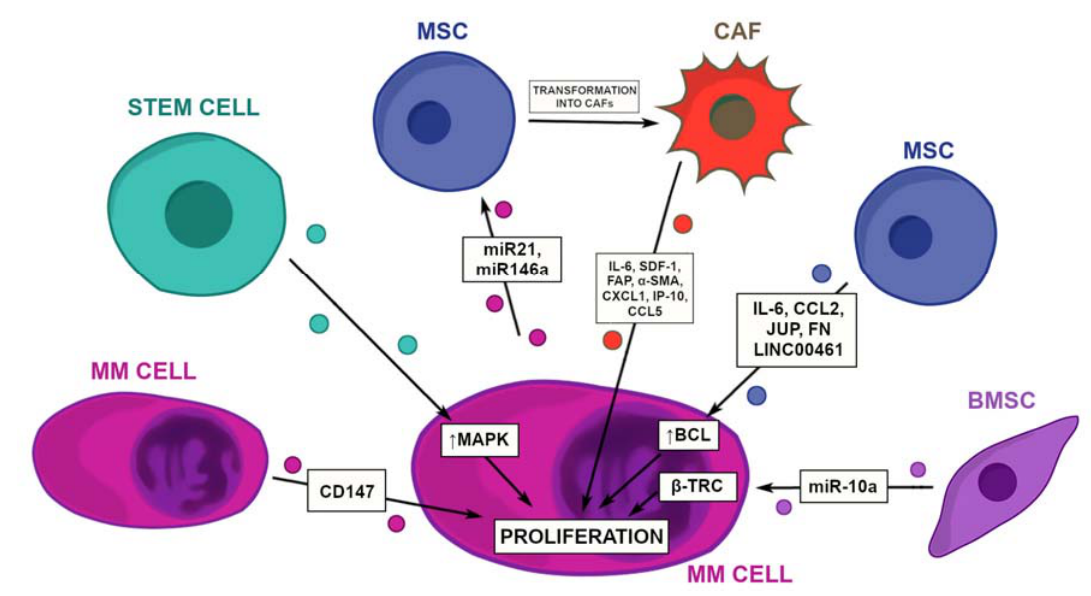
Figure 1. EVs’ involvement in the induction of the proliferation of MM cells. Interactions be- tween numerous stromal cells lead to tumor growth. MSCs send pro-proliferative cytokines, which increase the BCL-2 content inside MM cells, inducing its viability and survival. When stimulated by MM, EVs that contain miR-21 and miR-146a, transform into CAFs, which in- duce the proliferation of tumor cells by multiple cytokines. Stem cell-derived EVs